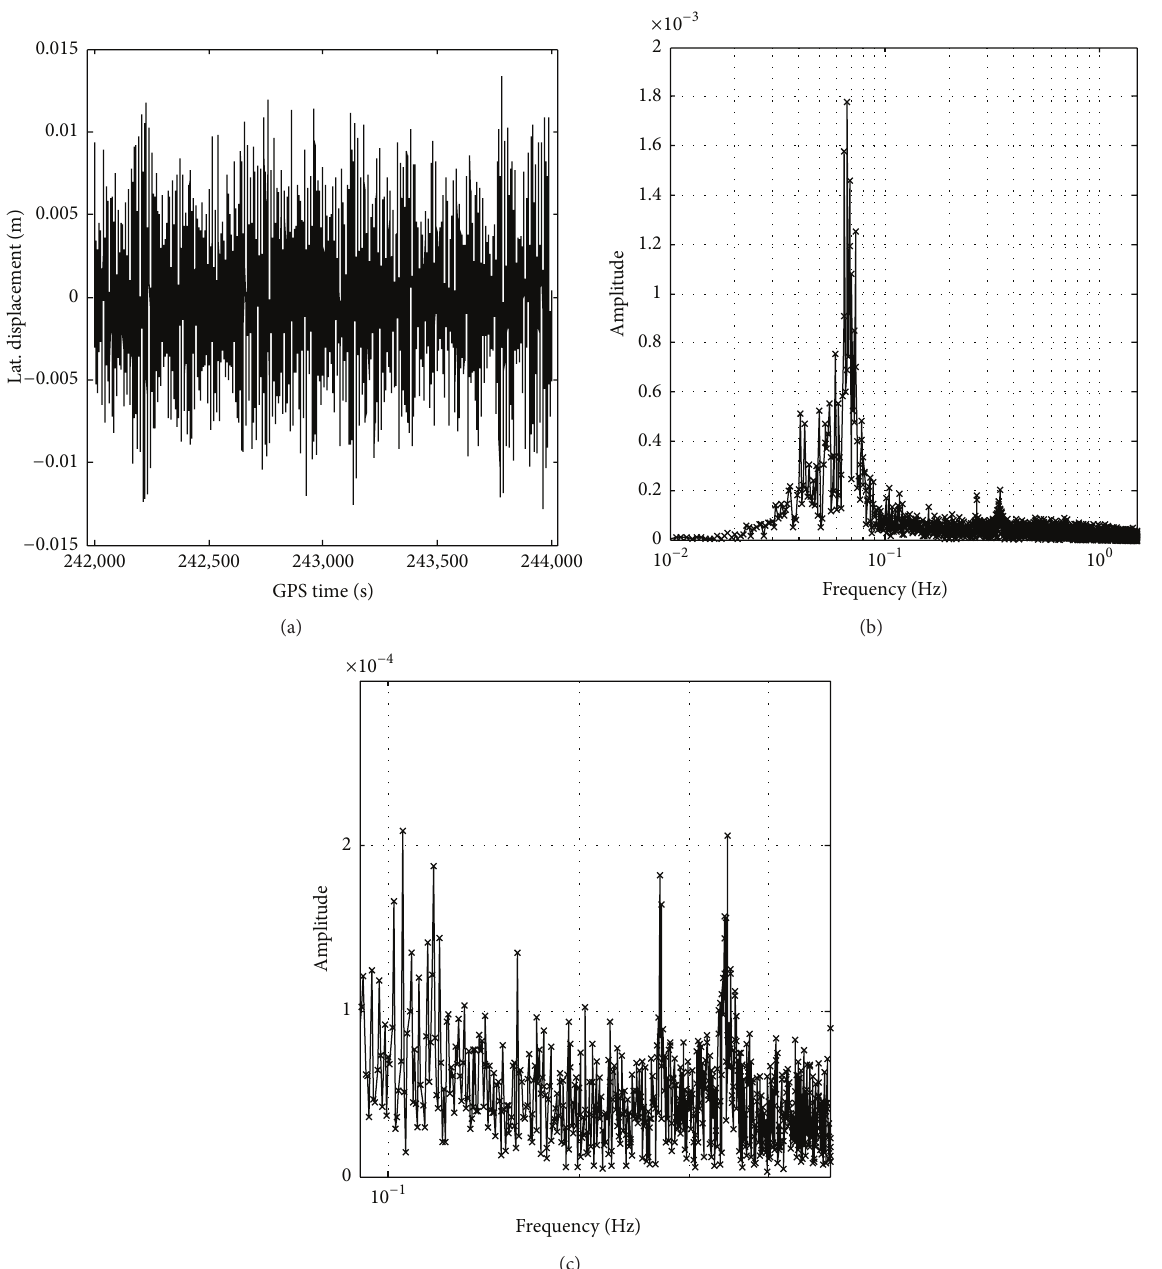
Figure 7: The filtered lateral displacements (a), corresponding vibration frequency ((b), full-scale band), and zoom-in of high frequency component